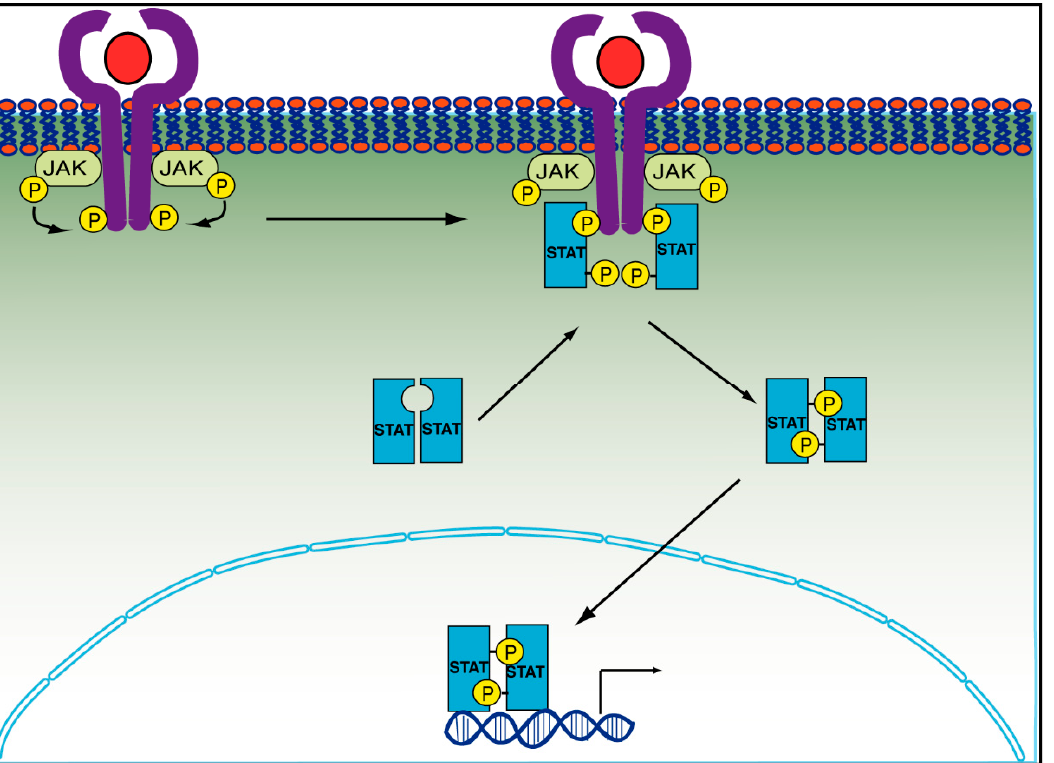
Figure 4. STAT pathway. After the interaction of the ligands with their corresponding receptors, associated tyrosine kinases, such as JAKs, are transphosphorylated to then phosphorylate the cyto- plasmic tail receptors. Then, STATs are recruited, and both are phosphorylated to form dimers that are translocated into the nucleus to activate gene transcription (see details in the text).